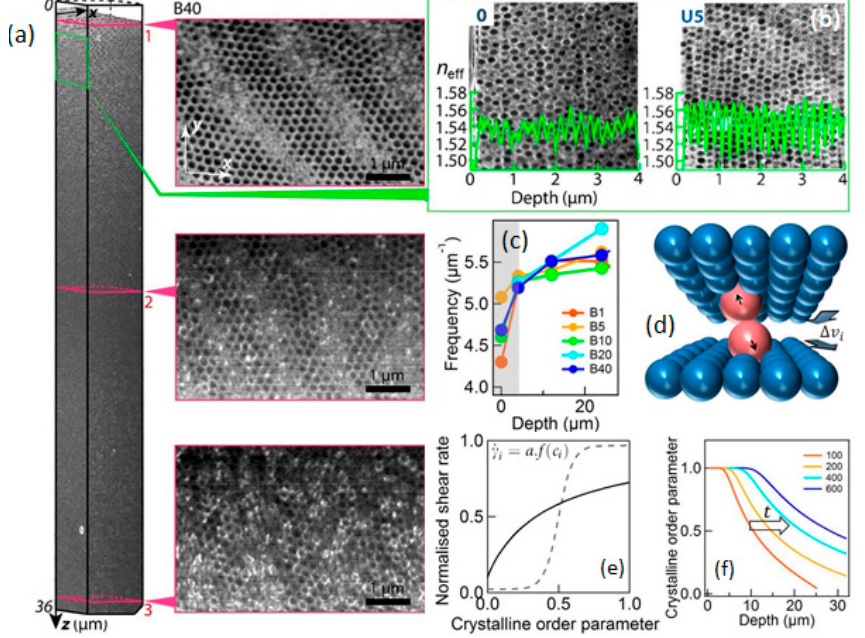
Figure 4. ( a ) Reconstructed 3D structure of PO sample after 40 oscillations of B-BIOS with horizontal slices extracted at depths labelled. Cuts are slightly tilted to the hcp planes, giving images of several neighbouring layers separated by blurred stripes; ( b ) Cross-section scanning electron microscopy (SEM) images of samples pre-BIOS (0), and after 5 oscillations of U-BIOS around different depths. Extracted n eff (z) variations (left axis) are superimposed (green); In parts ( a , b ), samples are pre-stained with RuO 4 to enhance the electron density contrast. Slices in xy planes normal to the sample surface are successively cut with focused ion beam (FIB), and imaged by in situ SEM. ( c ) Main spatial frequencies of n eff at different depths in B-BIOS samples; ( d ) illustrative model of ordering forces for individual spheres out of position, with interlayer relative velocity Δ v i . ( e ) Nonlinear transfer relation between normalized shear rate and crystalline order in each layer, for polymer opals (solid) and colloids (dashed). An order parameter of 0 represents disorder and 1 corresponding to perfect crystalline ordering; ( f ) Resulting crystalline order versus depth for increasing total strain applied (red to blue). (Adapted from Ref. [28] with permission of Nature Publishing Group).